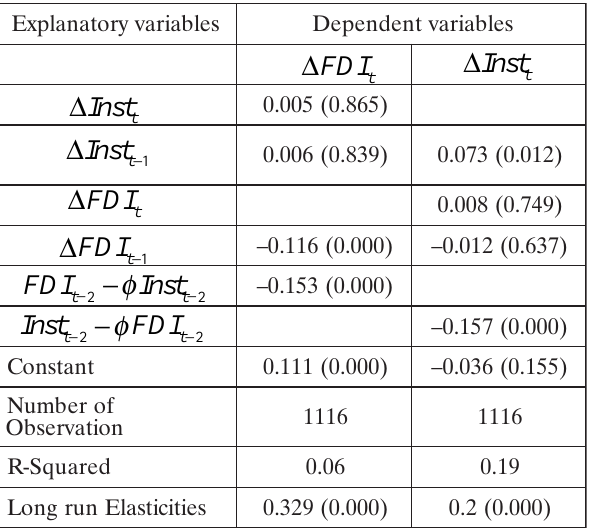
Table 5. Panel Error Correction Model (Two Step Fixed Effect